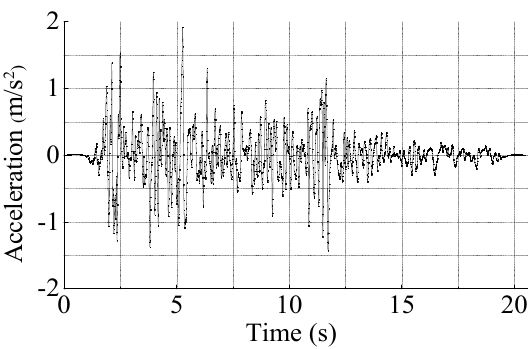
Figure 8. Time history curve of El Centro wave.